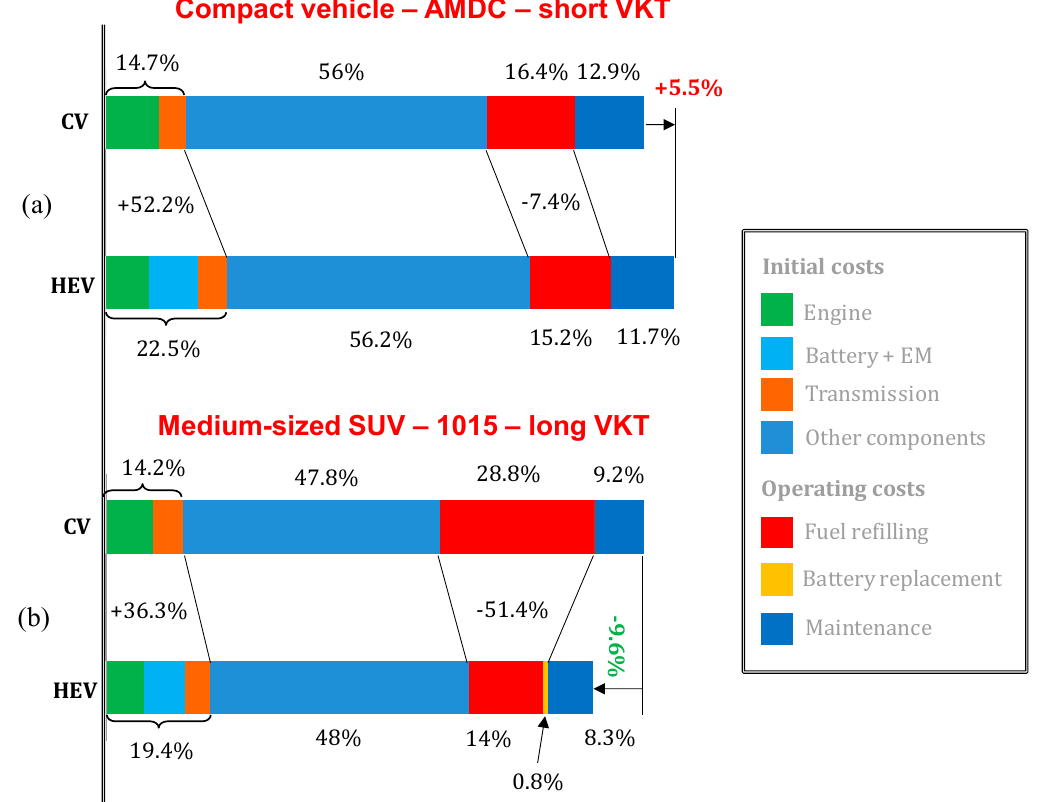
Figure 6. Cost comparison of the conventional and the hybrid vehicles for the compact segment over the AMDC mission for a short VKT ( a ) and for the medium-sized SUV segment over the 1015 mission for a long VKT ( b ).